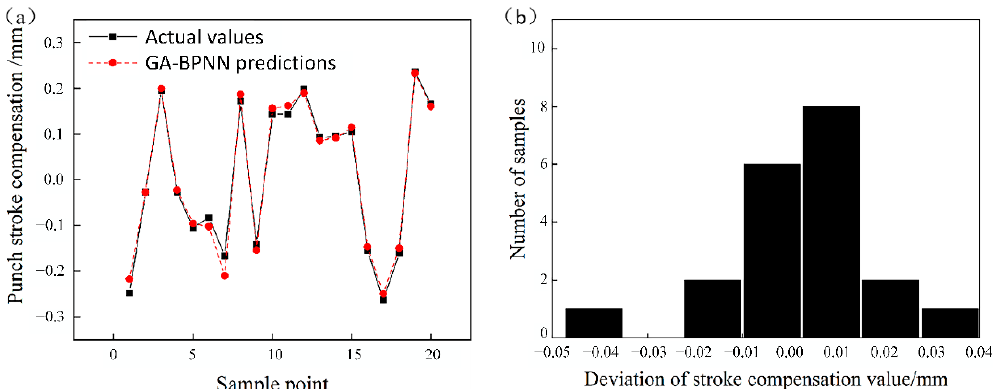
Figure 6. Regression values of network training.